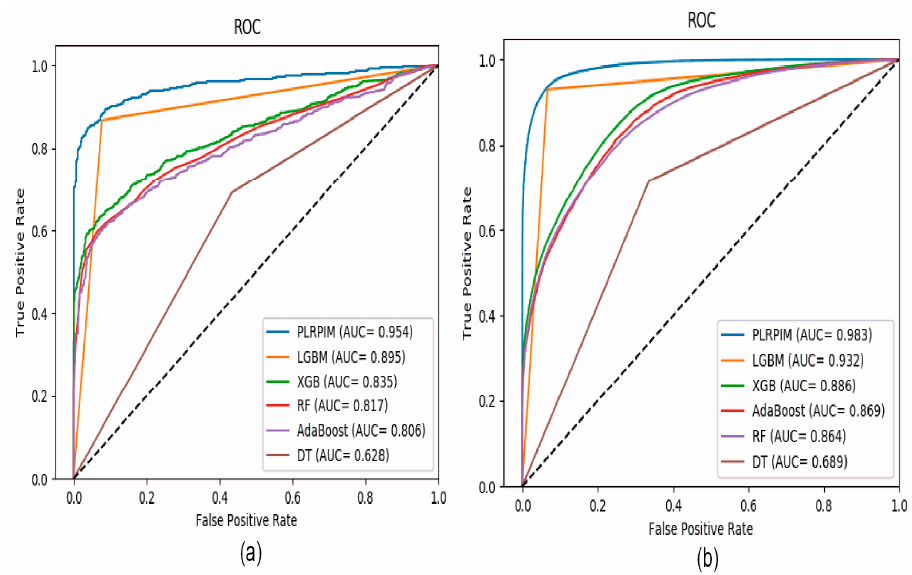
Figure 4. ROC curves for PLRPIM, light gradient boosting machine (LGBM), extreme gradient boost (XGB), random forest (RF), adaptive boosting (AdaBoost), and decision tree (DT) on ( a ) Arabidopsis thaliana dataset and ( b ) Zea mays dataset.